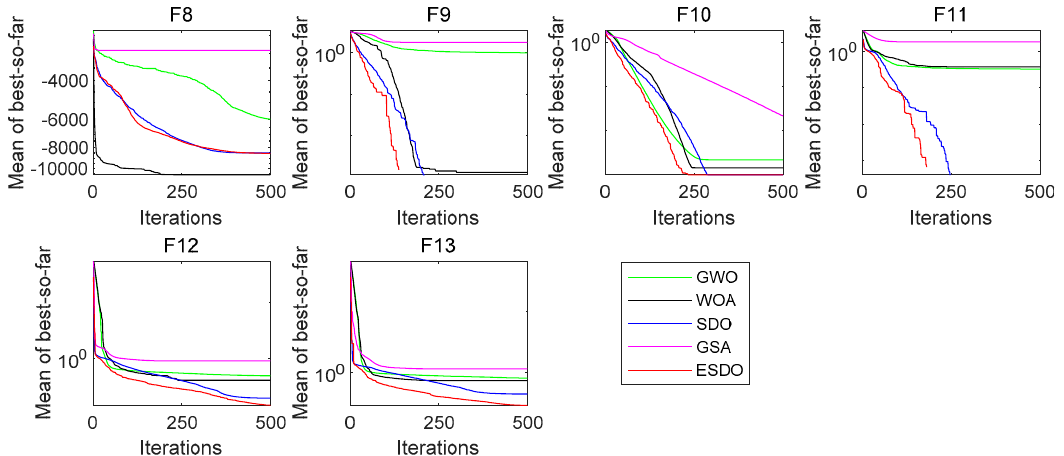
Figure 4. Convergence comparisons of MNs (F8–F13).